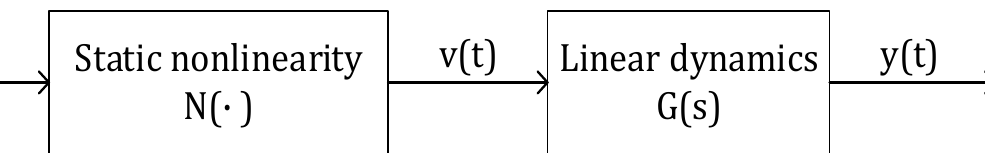
Figure 2. The structure of the classic Hammerstein model.